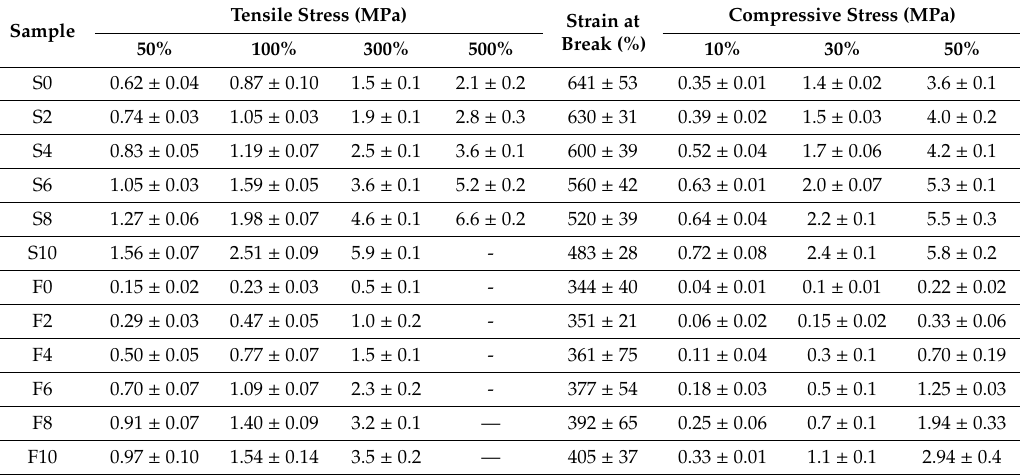
Table 2. Mechanical properties of solid and foamed EPDM / MWCNT nanocomposites.